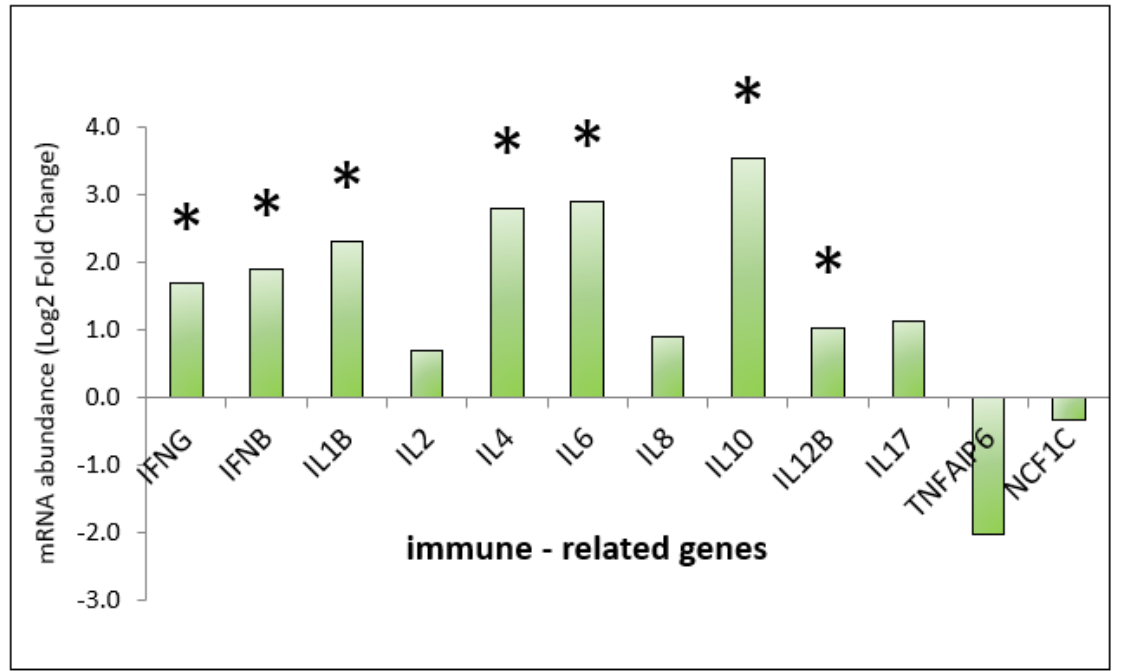
Figure 3. Relative gene expression of immune-related genes in cecal mucosa in chickens supple- mented with zeolite in feed and bedding. Statistical analysis consisted of comparing the experimental groups with the control group using Student’s t -test (* for p -value < 0.05).